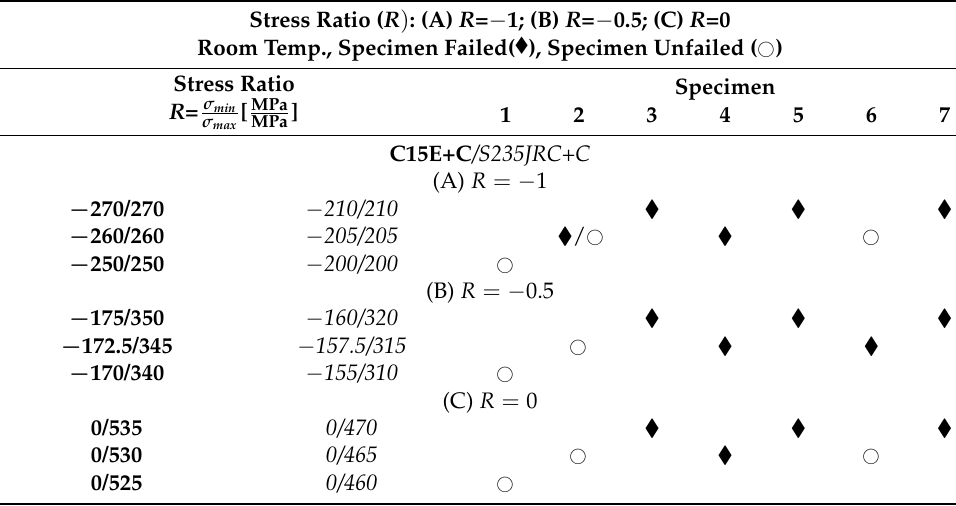
relationship of the levels of fatigue limits obtained for the tested materials at certain stress ratios. Table 2. Data for modified staircase method.